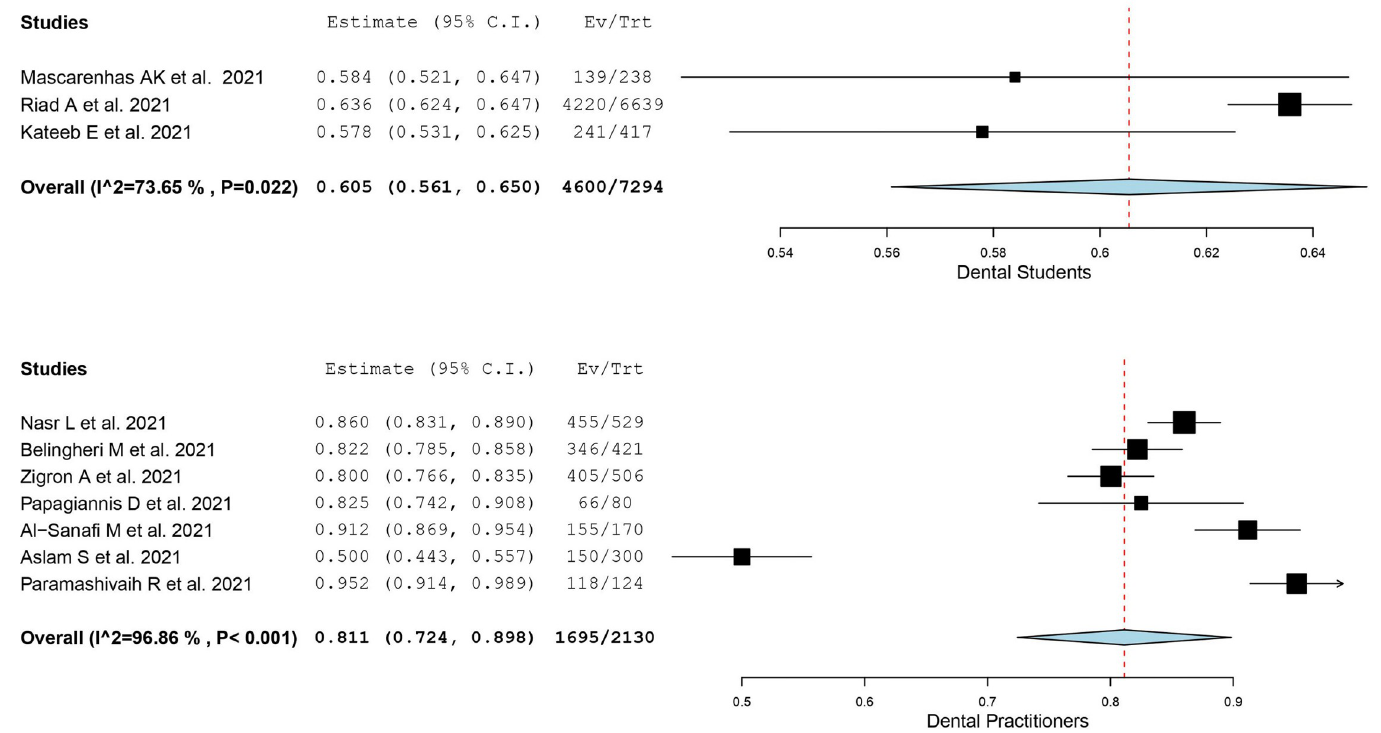
Fig 2. Meta-analysis of COVID-19 vaccine acceptance. Single-arm meta-analyses showing the weighted mean acceptance rates of COVID-19 vaccination among dental students and dental practitioners.